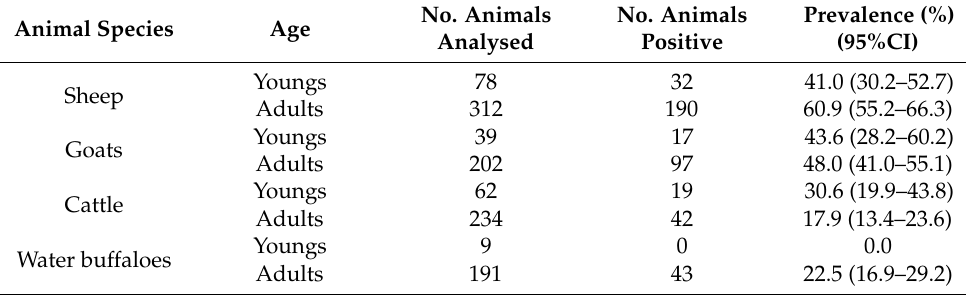
Table 2. Overall seroprevalence of T. gondii according to the age (youngs and adults) for each animal species (sheep, goats, cattle and water